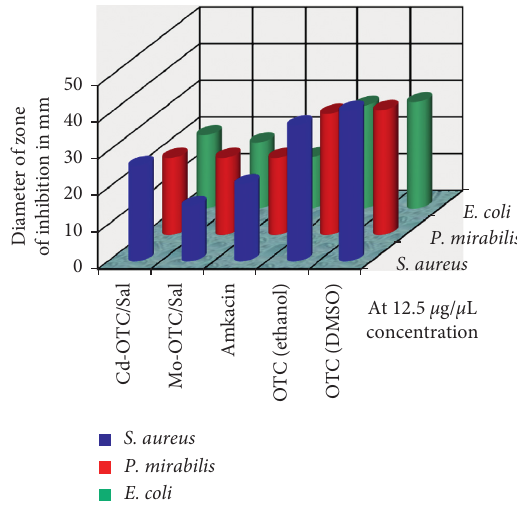
Figure 10: Bar graph showing antibacterial sensitivity at 12.5 μ g/ μ L